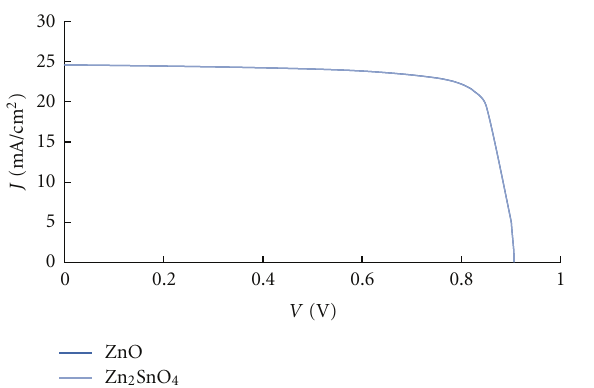
Figure 6: E ff ect of ZnO and Zn 2 SnO 4 on the current-voltage characteristics of the solar cell.